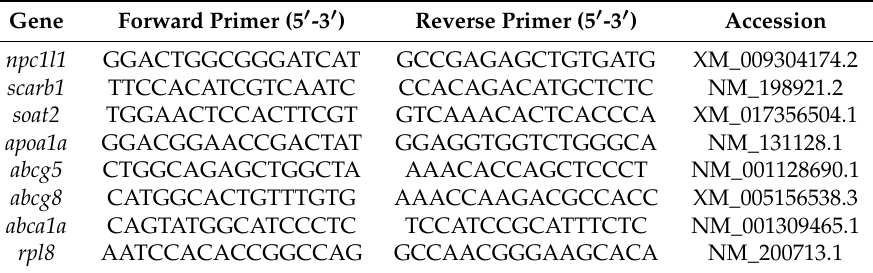
Table 2. Gene name and primer sequence for real-time